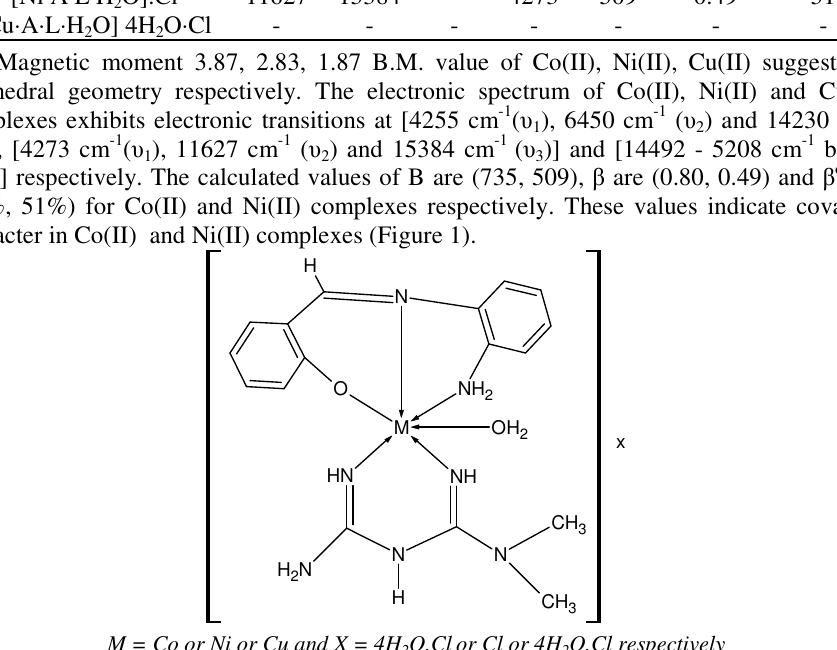
Absorption region, cm -1